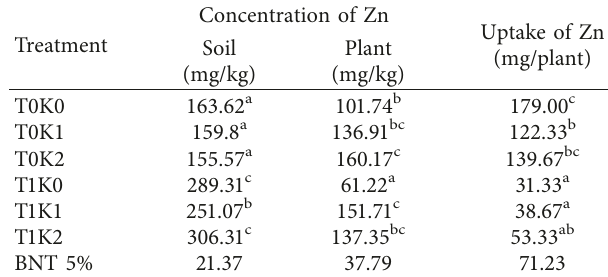
Table 4: Level of Zn metal on soil and sunflower plants.